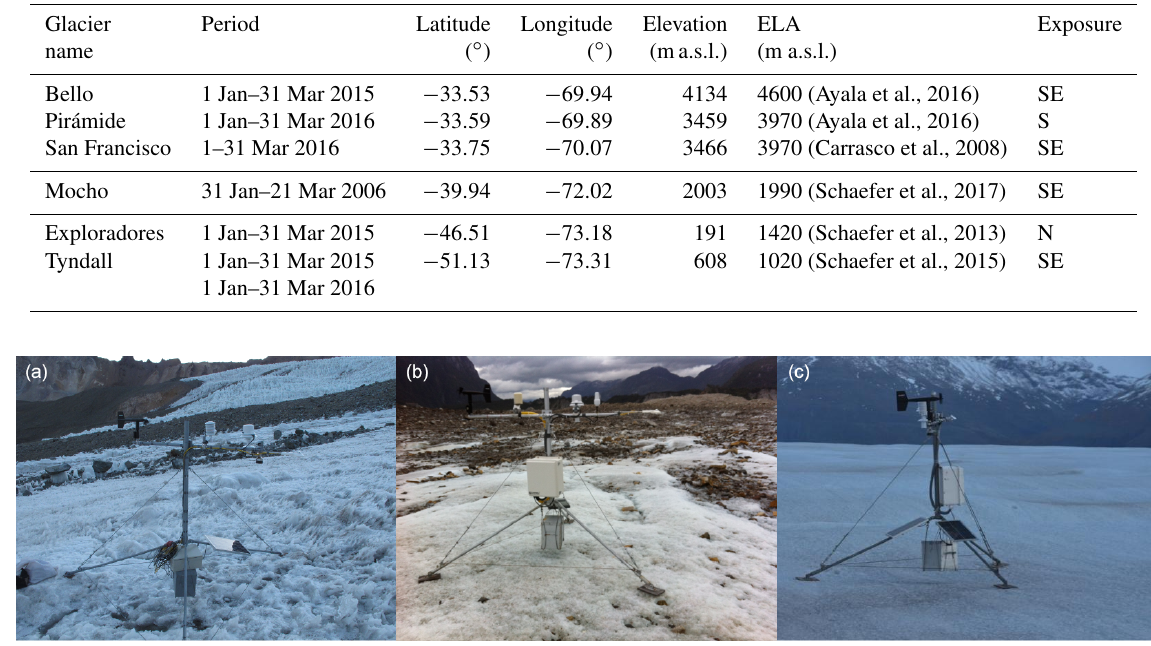
Figure 2. AWS on Bello Glacier (a) , Exploradores Glacier (b) and Tyndall Glacier (c)